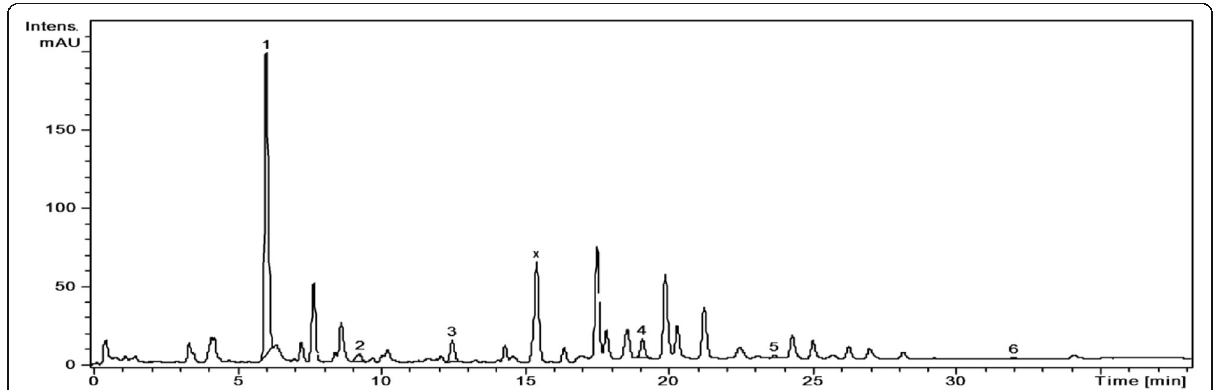
Fig. 1 HPLC chromatograms of N. pseudonarcissus extract. Notes: The identified compounds: 1-chlorogenic acid; 2- p -coumaric acid; 3-ferulic acid; 4-hyperoside; 5-quercitrin;